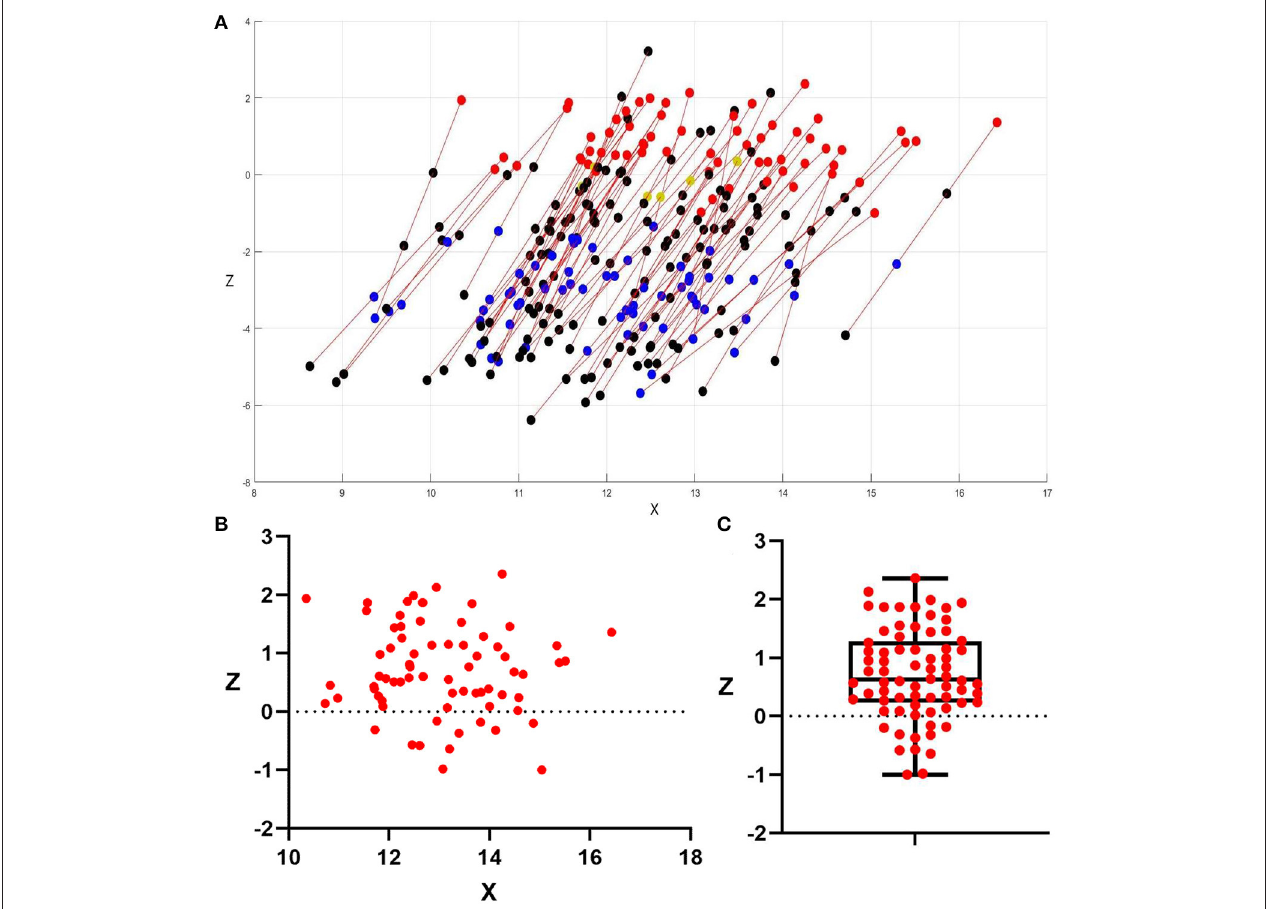
FIGURE 3 | Distribution of electrode and active contacts. (A) Distribution of 72 electrodes which got good LID management, and all DBS electrodes were mapped to the right side to allow for direct comparison. The X -coordinate is positive toward the lateral. Unipolar stimulation in 6 electrodes (yellow plots are active contacts) and double monopolar stimulation or interleaving stimulation in 66 electrodes (red and blue plots are active contacts); red plots and yellow plots were the contacts corresponding to good anti-dyskinesia effect, while blue plots were the contacts corresponding to good effect for PD motor symptoms but without anti-dyskinesia effect; black plots were inactive contacts. (B) Distribution of the 72 active contacts which showed successful anti-dyskinesia effect, 2D diagram in an anterior view; (C) Z -coordinate of the 72 active contacts which showed successful anti-dyskinesia effect: 0.72 ± 0.78mm ( − 1 ∼ 2.36mm). The values were presented as mean ± standard deviation (minimum–maximum); 61/72 (85%) were above the anteroposterior commissure plane ( Z =